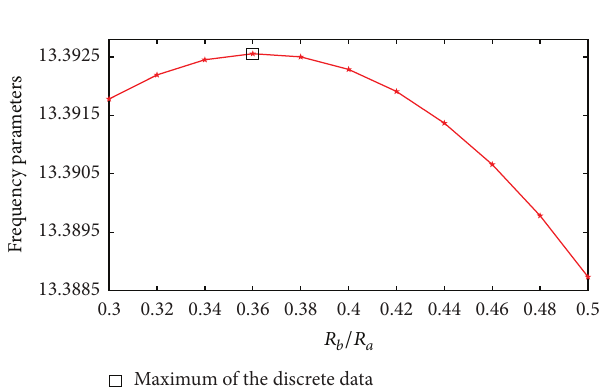
Figure 8: The first mode frequency as a function of curvature ratio for an F-F-F-F shell.